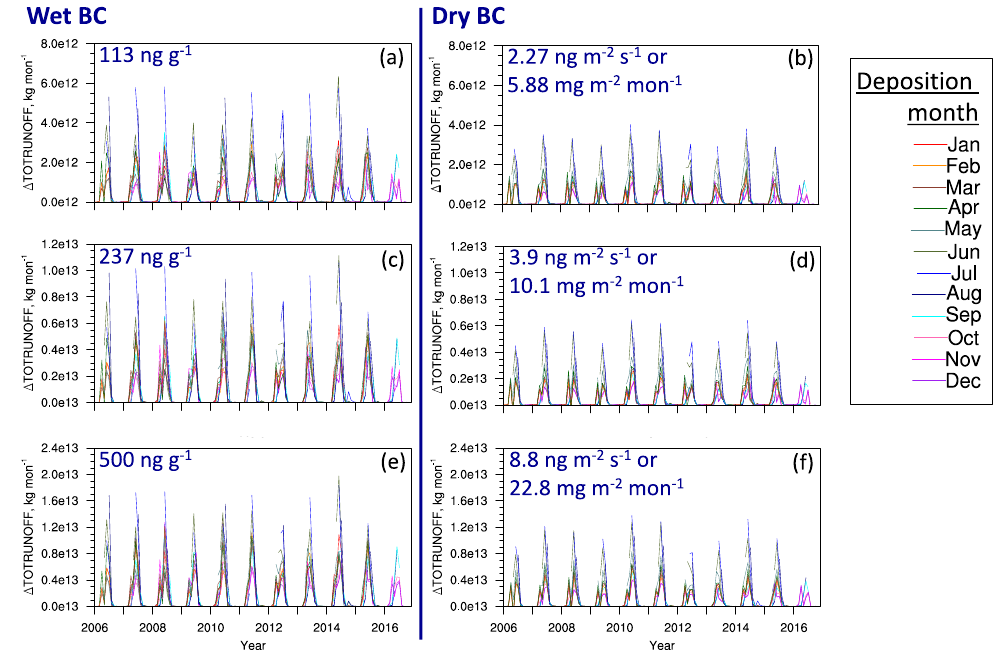
Figure 9. Monthly time series of the increase in total Greenland runoff resulting from BC deposition. Values of BC concentrations in precipitation (a, c, e) and dry deposition fluxes (b, d, f) are shown in each plot. Each line starts from the BC deposition month and extends 1 year. Different line colors represent different deposition months.